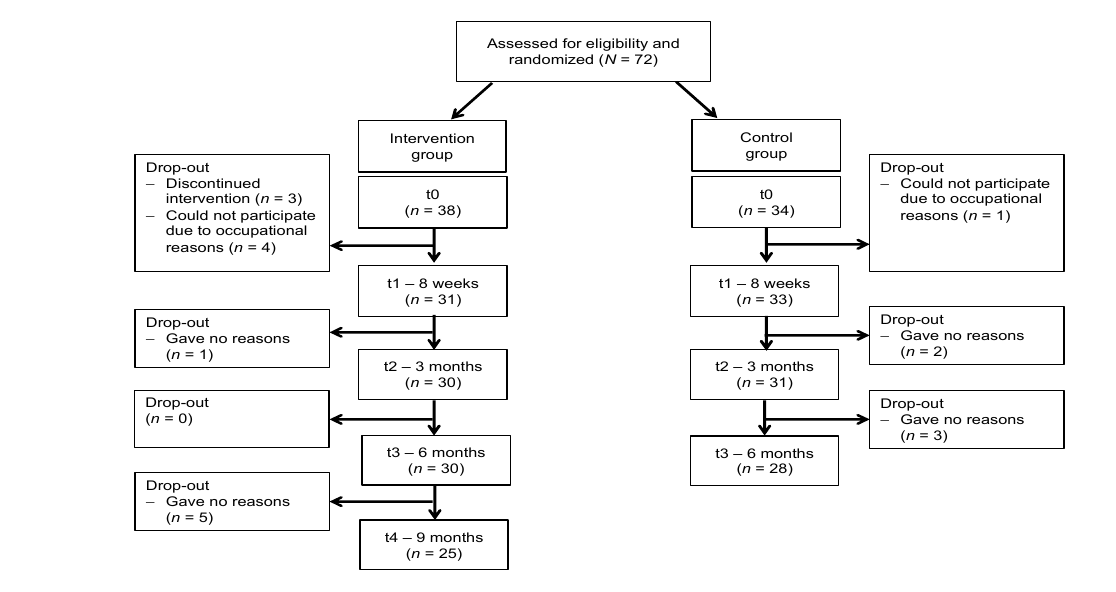
Figure 1. Flowchart of the study. Table 1. Socio-demographic characteristics of the sample at baseline, t0 (N =